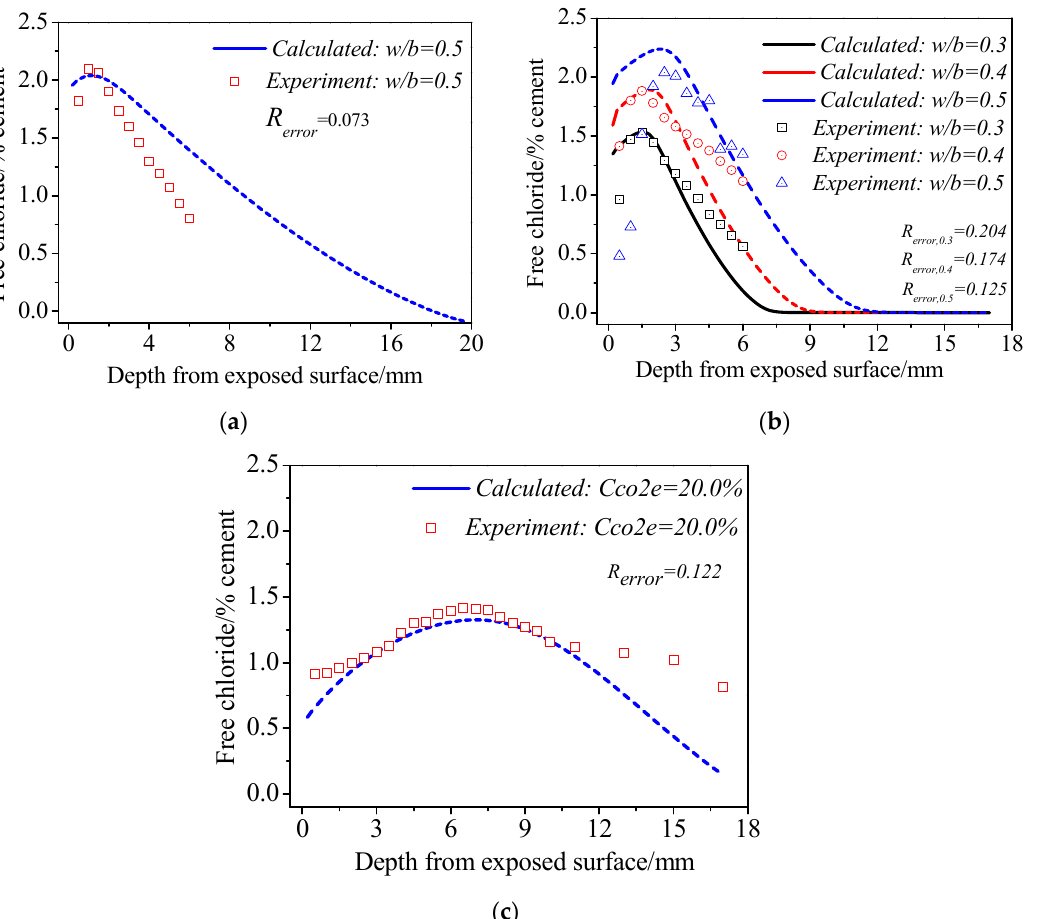
Figure 5. Comparison between experimental results and calculated results: ( a ) N 2 condition ( C CO2e = 0); ( b ) normal air condition ( C CO2e = 0.04%); ( c ) accelerated carbonation condition ( C CO2e =